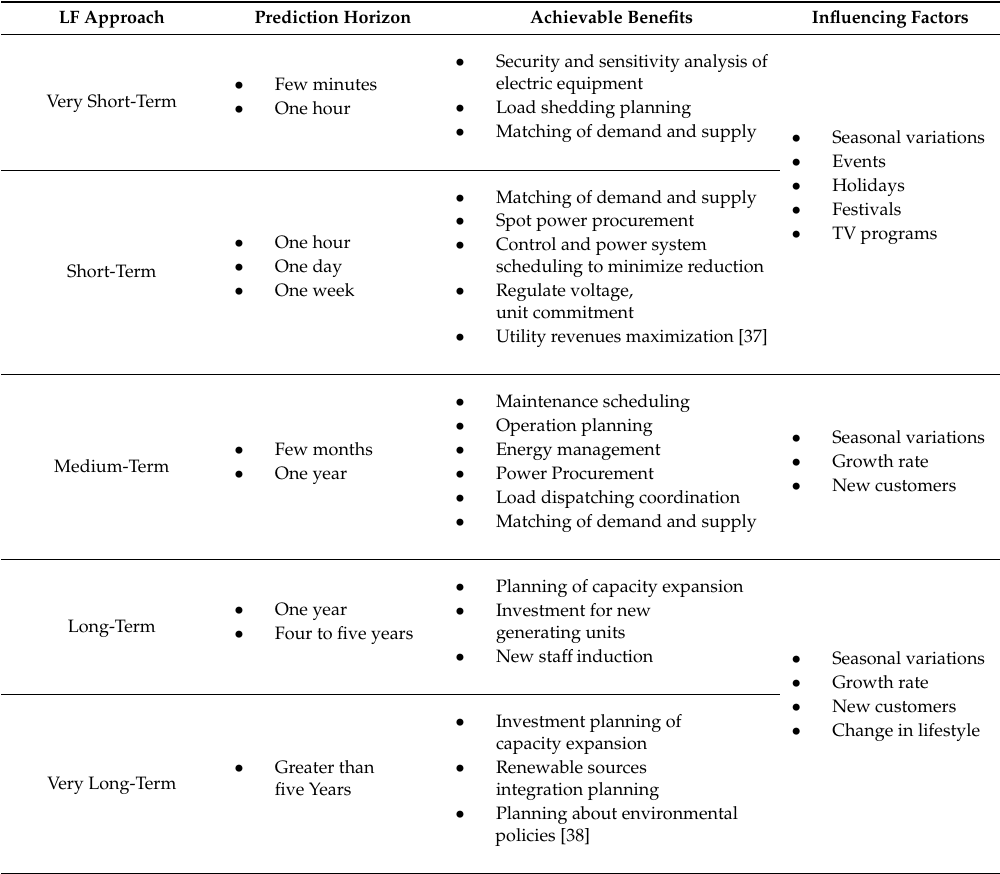
Table 1. Comprehensive Summary of Load Forecasting (LF) classes, prediction horizons achievable benefits, and influencing